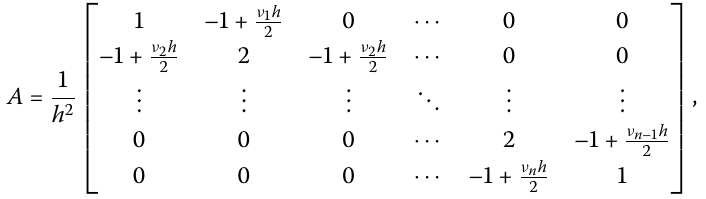
and e ( k ) of the Newton method 1 2